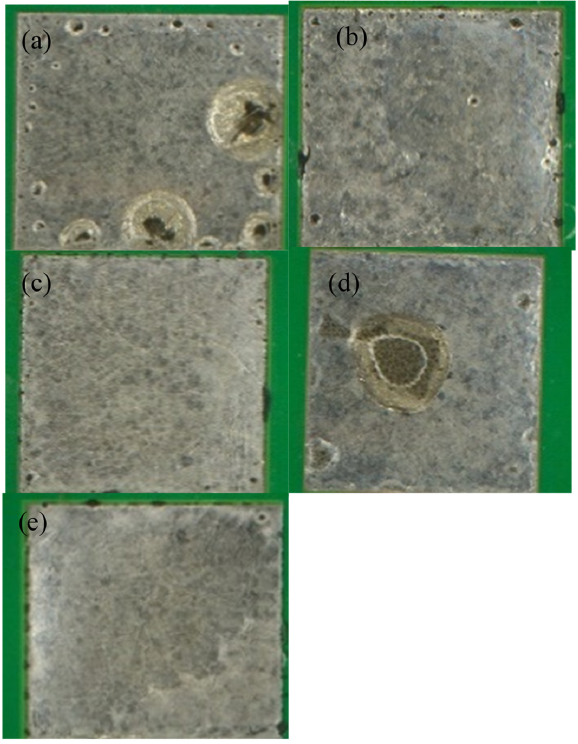
Figure 6. Optical images of LT 51 reflowed with ( a ) a peak temperature of 165 °C and 45 s TAL, ( b ) peak temperature of 165 °C and 90 s TAL, ( c ) peak temperature of 177 °C and 45 s TAL, ( d ) peak temperature of 177 °C and 90 s TAL and ( e ) peak temperature of 190 °C and 90 s TAL Table 3. Examination of solder coverage of copper pad as a function of reflow profiles.